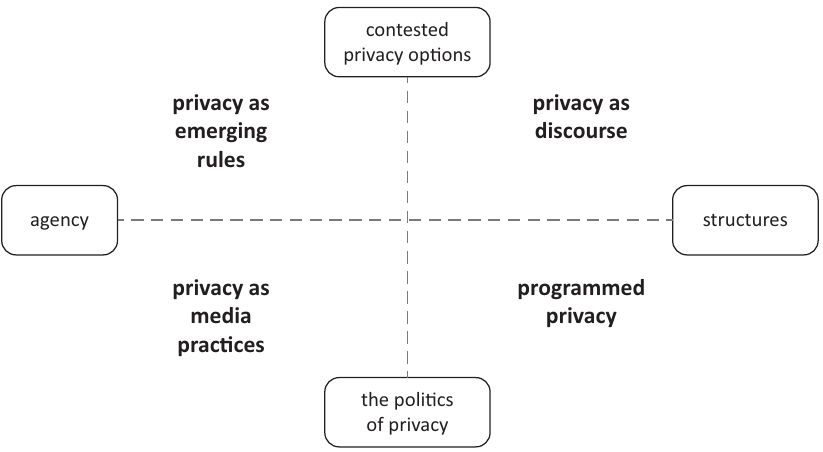
Figure 1. Four perspectives on the political implications of privacy. is not about data protection but about the appropriate flow of information. Focusing on the outcomes—that